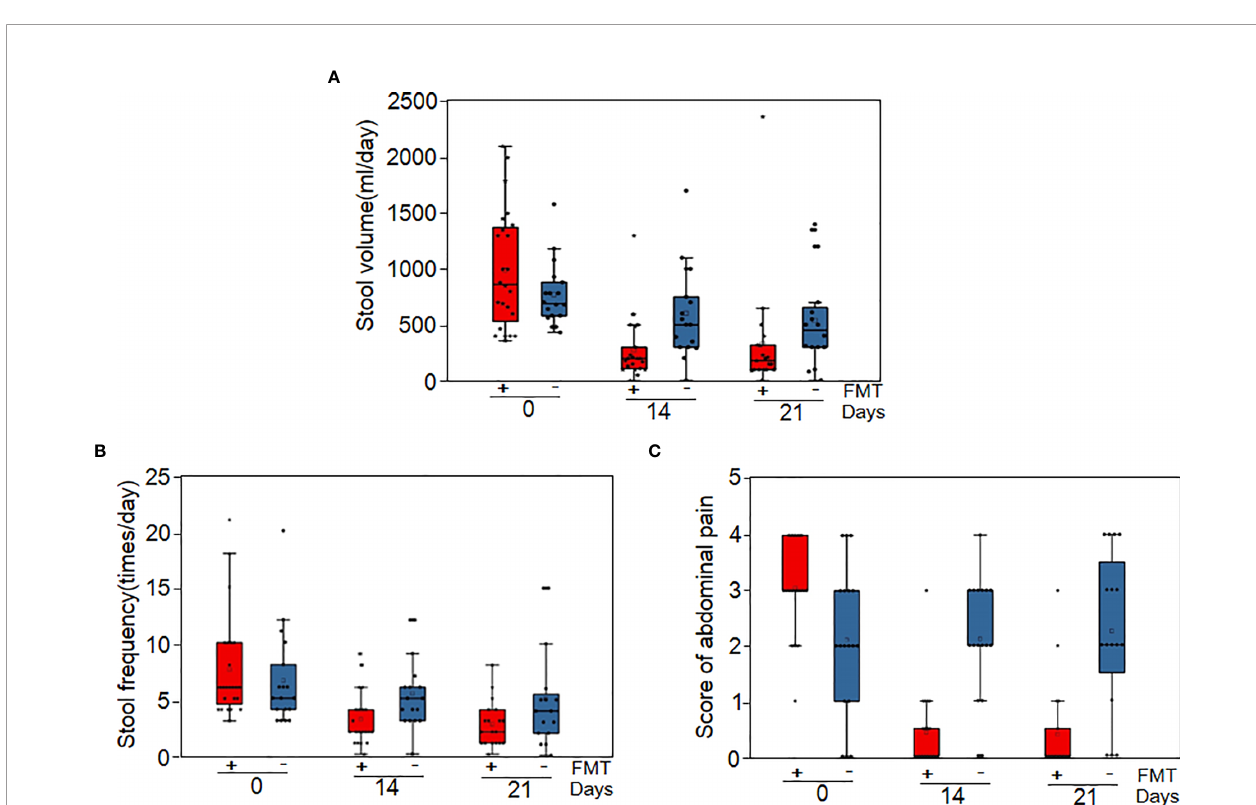
FIGURE 2 | Clinical response to FMT. (A) Stool volumes of all patients at baseline, Day 14 and Day 21 after steroid-refractory GI-GvHD was diagnosed. (B) Stool frequency of all patients at baseline, Day 14 and Day 21 after steroid-refractory GI-GvHD was diagnosed. (C) Abdominal pain score of all patients at baseline, Day 14 and Day 21 after steroid-refractory GI-GvHD was diagnosed.